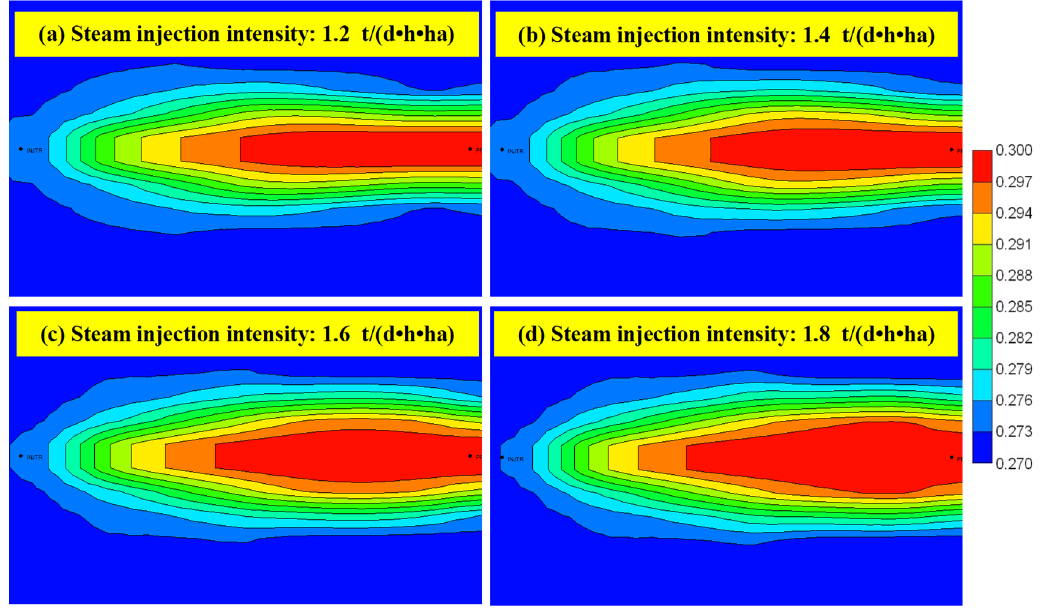
Figure 20. Porosity distribution after steam flooding under different steam injection intensity.